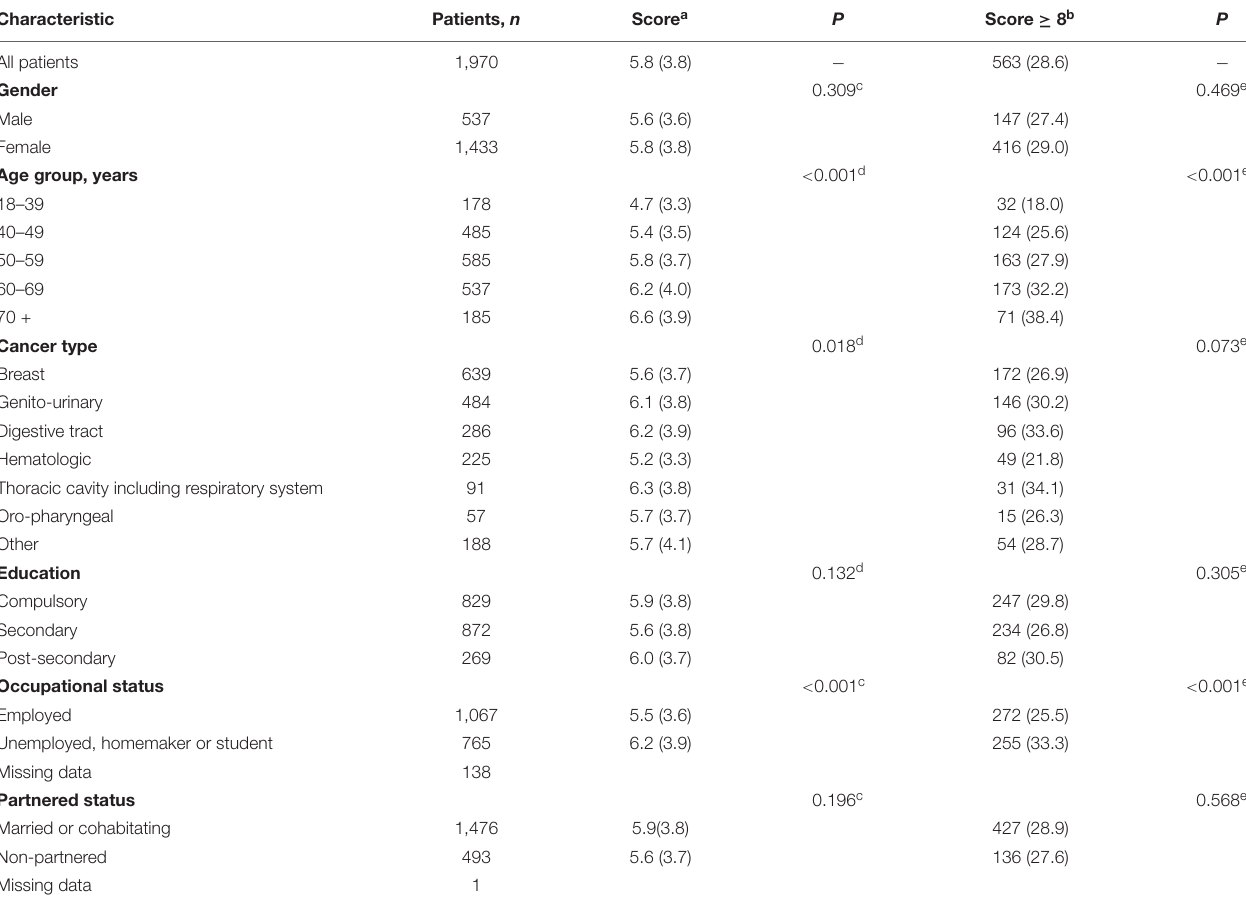
TABLE 3 | Depression intensity scores and prevalence according to HADS-D, by sociodemographic and clinical characteristic. Characteristic Patients,